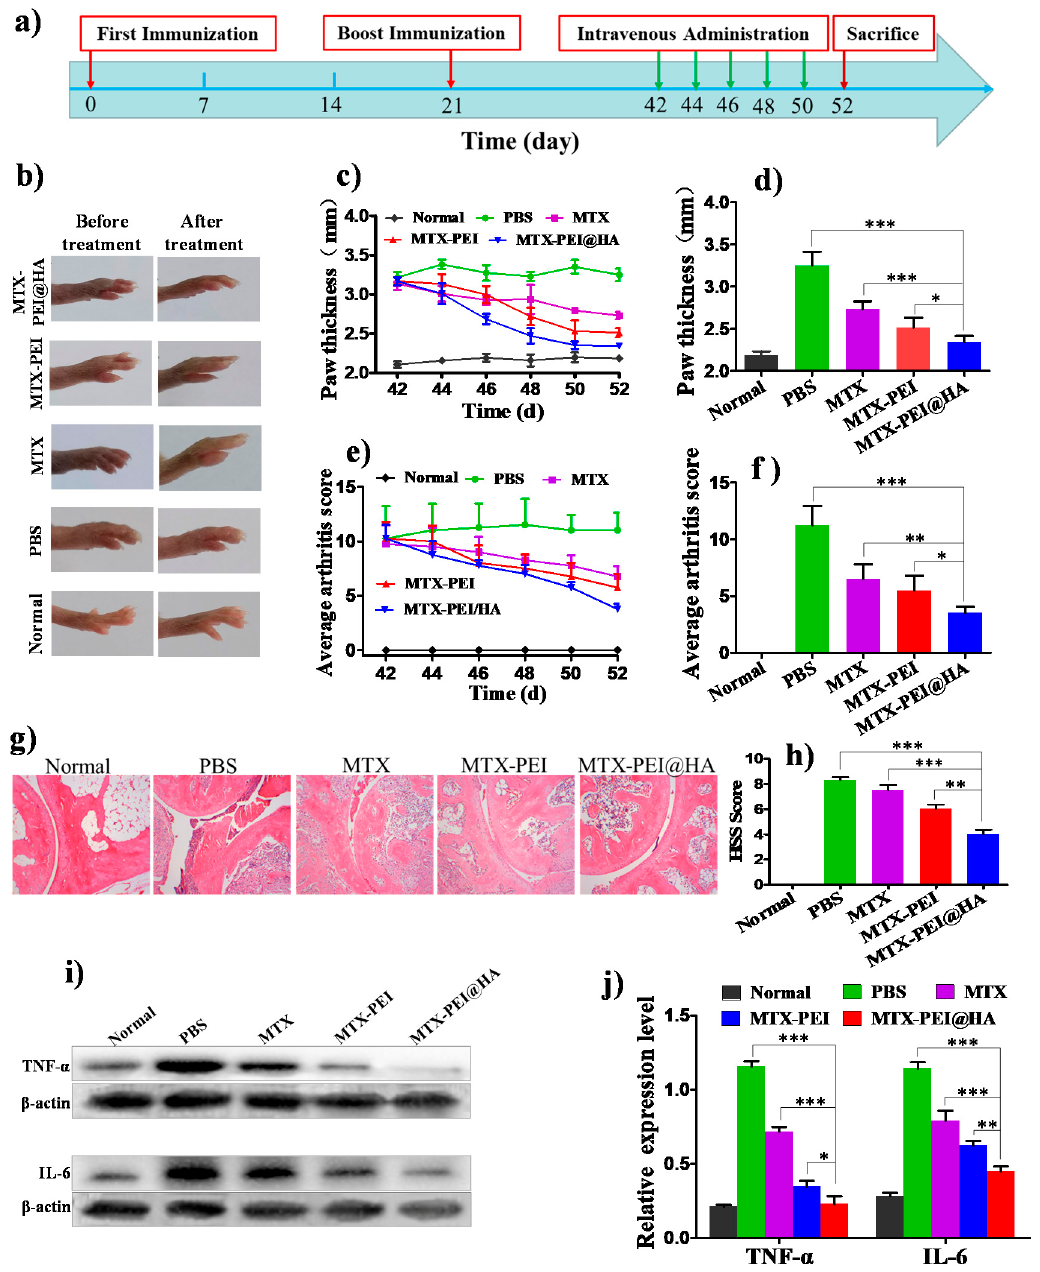
Figure 4. Therapeutic efficacy of MTX-PEI@HA NPs in collagen-induced arthritis (CIA) mice. ( a ) The overall experimental timeline for in vivo experiment. ( b ) Photographs of DBA/1 mice paws treated with different formulations. ( c ) The severity of arthritis assessed by measuring hind paw thickness over time ( d ) The hind paw thickness measured 2 days after the last injection. ( e ) Mice were scored according to the disease progression. ( f ) The clinical arthritis score evaluated 2 days after the last injection. ( g ) Histological analysis with hematoxylin-eosin (H&E) of joint tissues extracted from mice of different treatment groups. ( h ) Histological synovitis score (HSS) of joint tissues extracted from different treatment groups. ( i ) The inflammatory cytokine (IL-6, TNF- α ) levels in joints of the mice detected by Western blot after different treatment. ( j ) Semi-quantitative image analysis of the bands from ( i ). * p < 0.05, ** p < 0.01, *** p < 0.001.